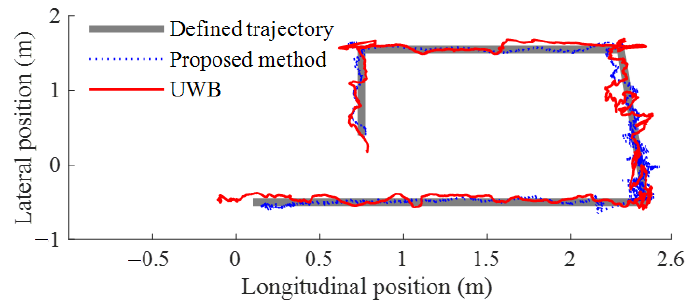
Figure 11. Comparative test results.